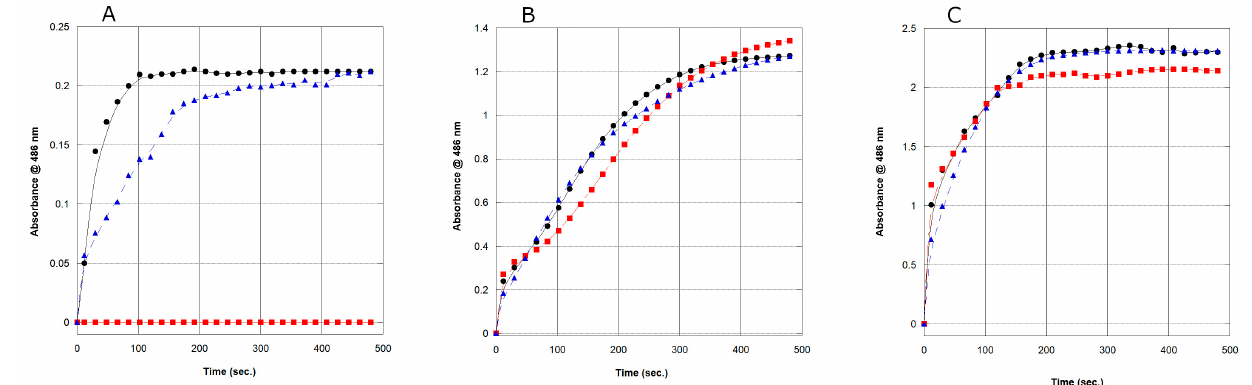
Figure 3. Hydrolysis of nitrocefin by the rAmpC proteins from E. cloacae 13047 ( A ), C. neteri 33855 ( B ), and C. neteri SSMD04 ( C ) in the absence (solid circle) and presence of either 2 mM clavulanic acid (red square) or 2 mM EDTA (blue triangle). For each panel, all reactions contained 500 nM rAMpC protein and 500 µM nitrocefin. Each data point represents the average of three experiments and the standard error was ≤ 5%.